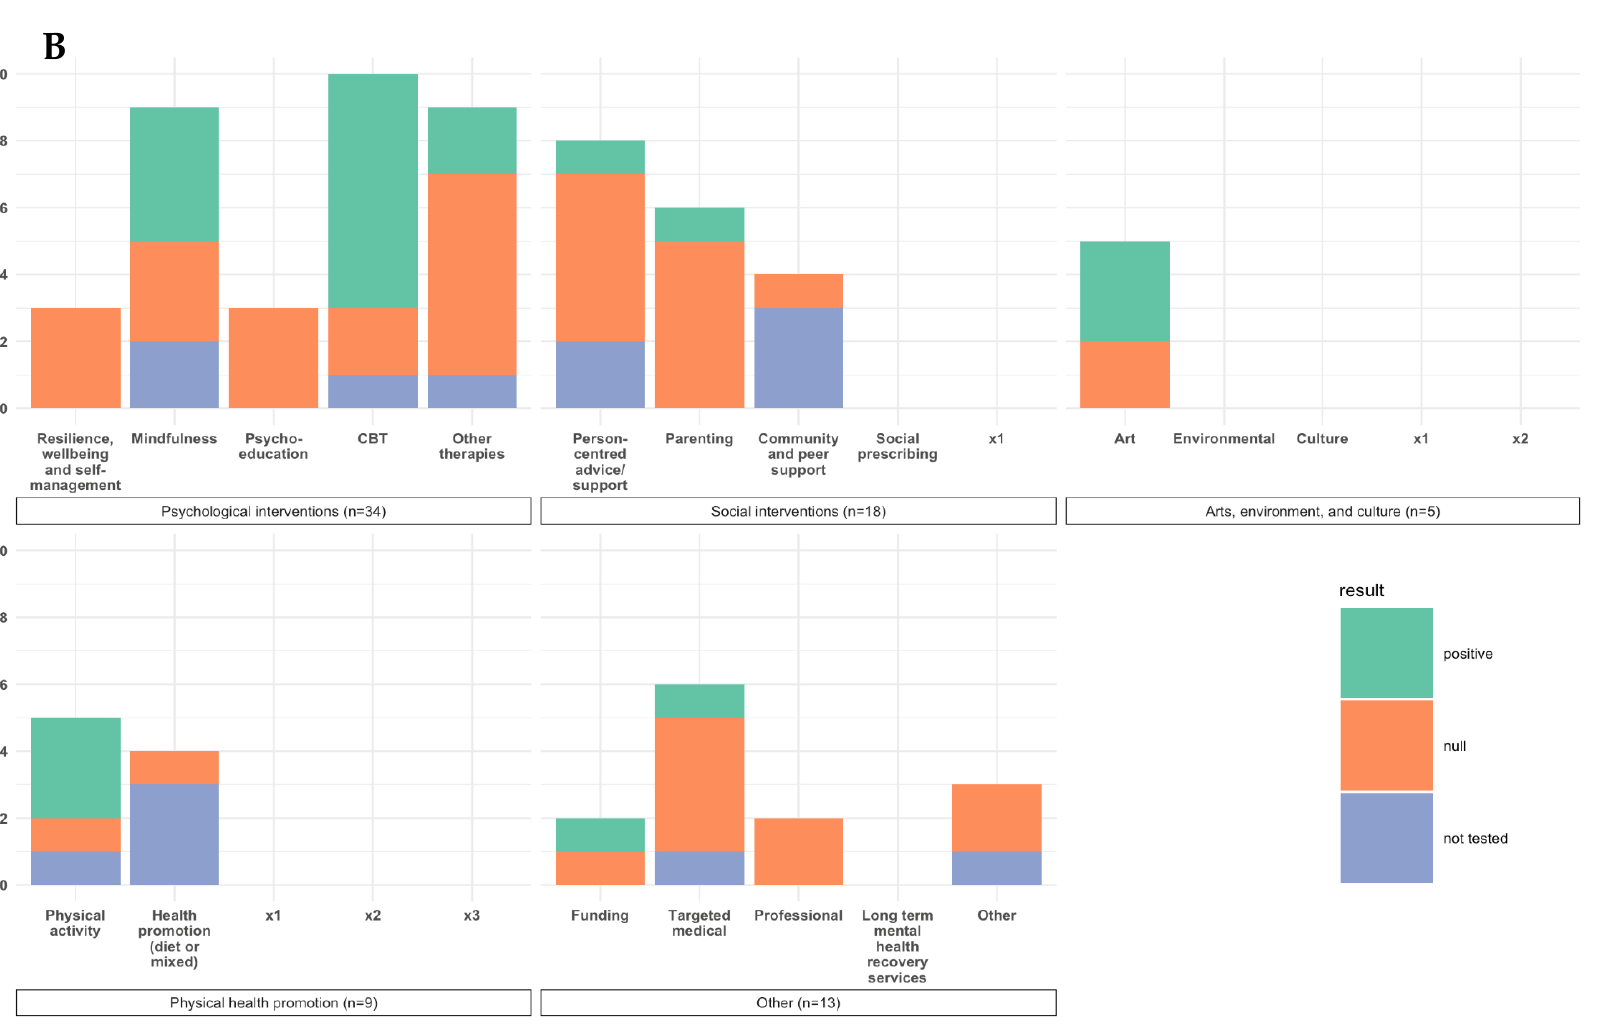
Figure 2. Intervention types and effect on wellbeing for: ( A ). difference in pre and post WEMWBS score in intervention group (n = 223); ( B ). difference between intervention and control group (n =79).